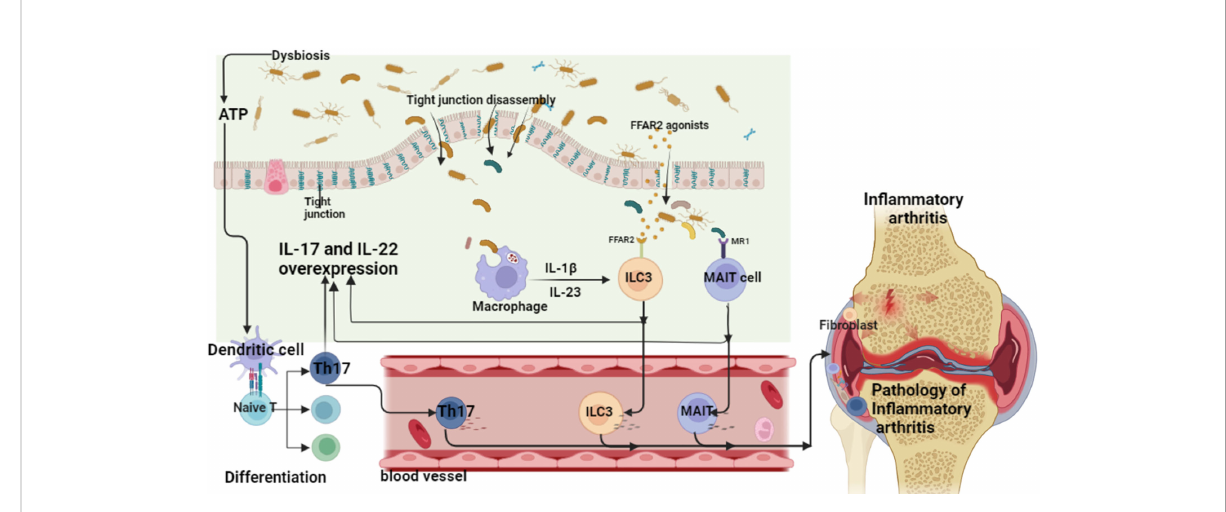
FIGURE 13 In fl ammatory arthritis - the pathogenic mechanism of the “ gut-arthritis ” axis (ATP, adenosine triphosphate; IL, interleukin; ILC, innate lymphoid cells; MAIT cell, mucosal associated invariant T; Th17, T helper cell